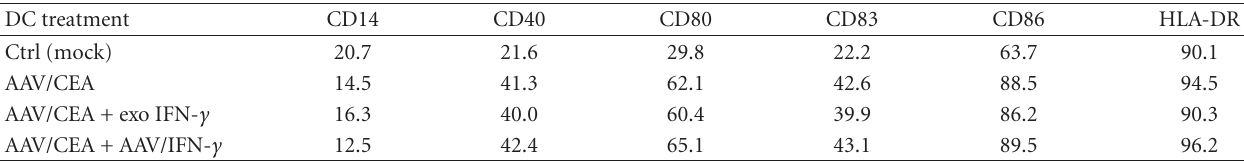
Table 1: Surface expression of CD molecules on DC, as percentage.